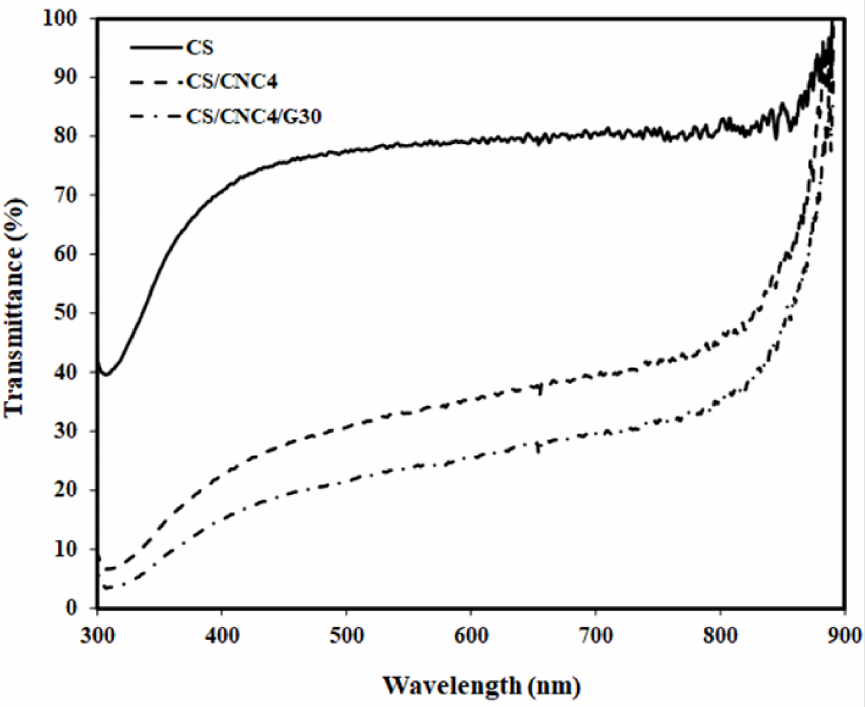
Figure 7. Light transmittance of the chitosan films and its bio-composite with 4 wt% CNC and with 30 wt%